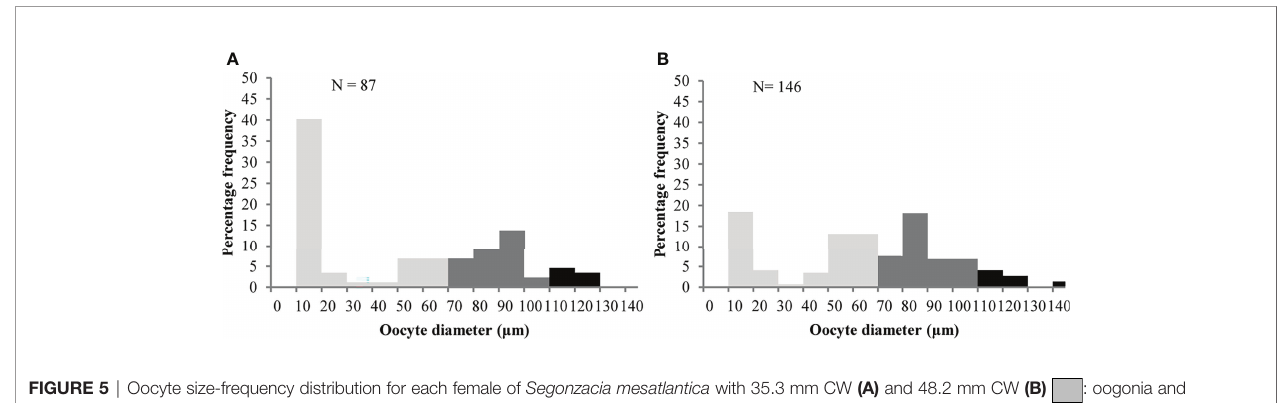
FIGURE 5 | Oocyte size-frequency distribution for each female of Segonzacia mesatlantica with 35.3 mm CW (A) and 48.2 mm CW (B) : oogonia and previtellogenic oocytes; Early previtellogenic oocytes; vitellogenic oocytes.